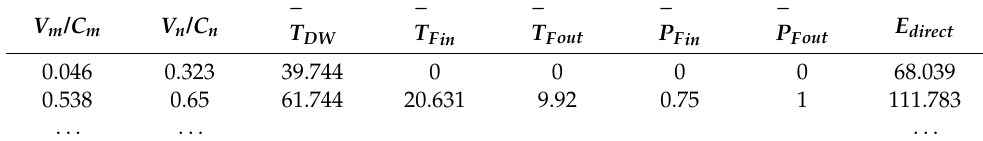
Table 6. Summary of direct carbon emission parameters during parking in scenario A (example).